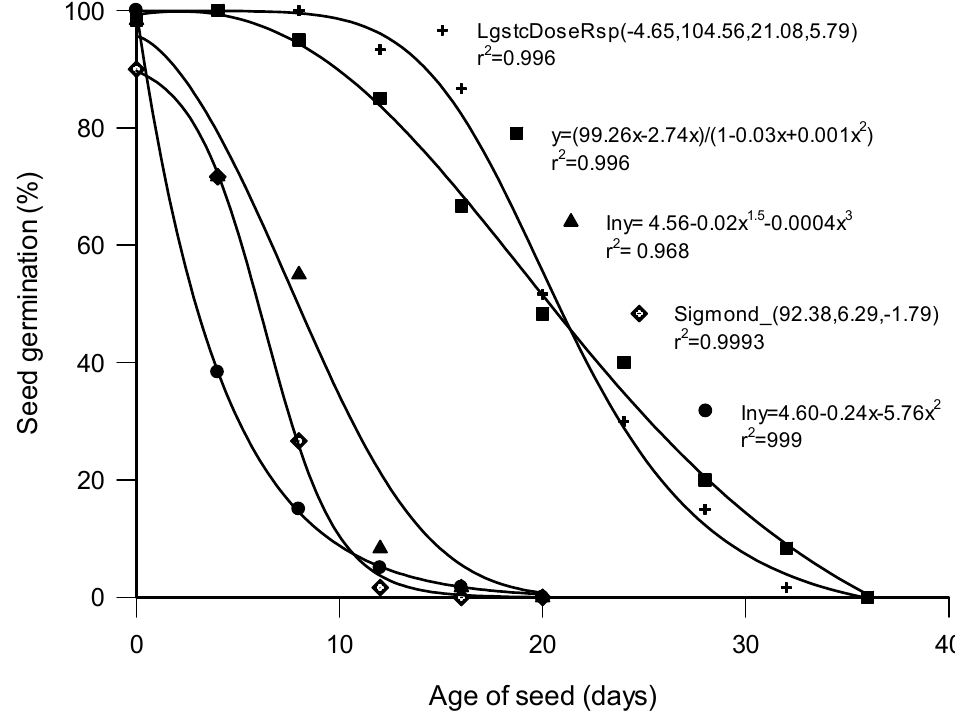
Figure 3. Loss of germination in Bolusanthus speciosus ( ● ), Combretum erythrophyllum ( ◊ ), Erythrina caffra ( ▲ ), Pisum sativum ( ■ ), and Cucurbita pepo (+) subjected to controlled dete- rioration at 40 ° C and 100% relative humidity.